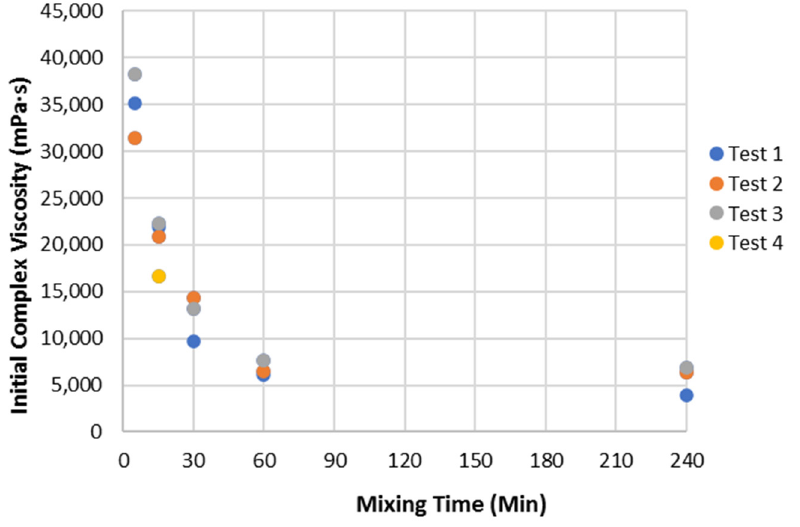
Figure 4. Effect of mixing time on the complex viscosity in the LVE range for 25% solid mixtures of 90 PDI soy flour in water.